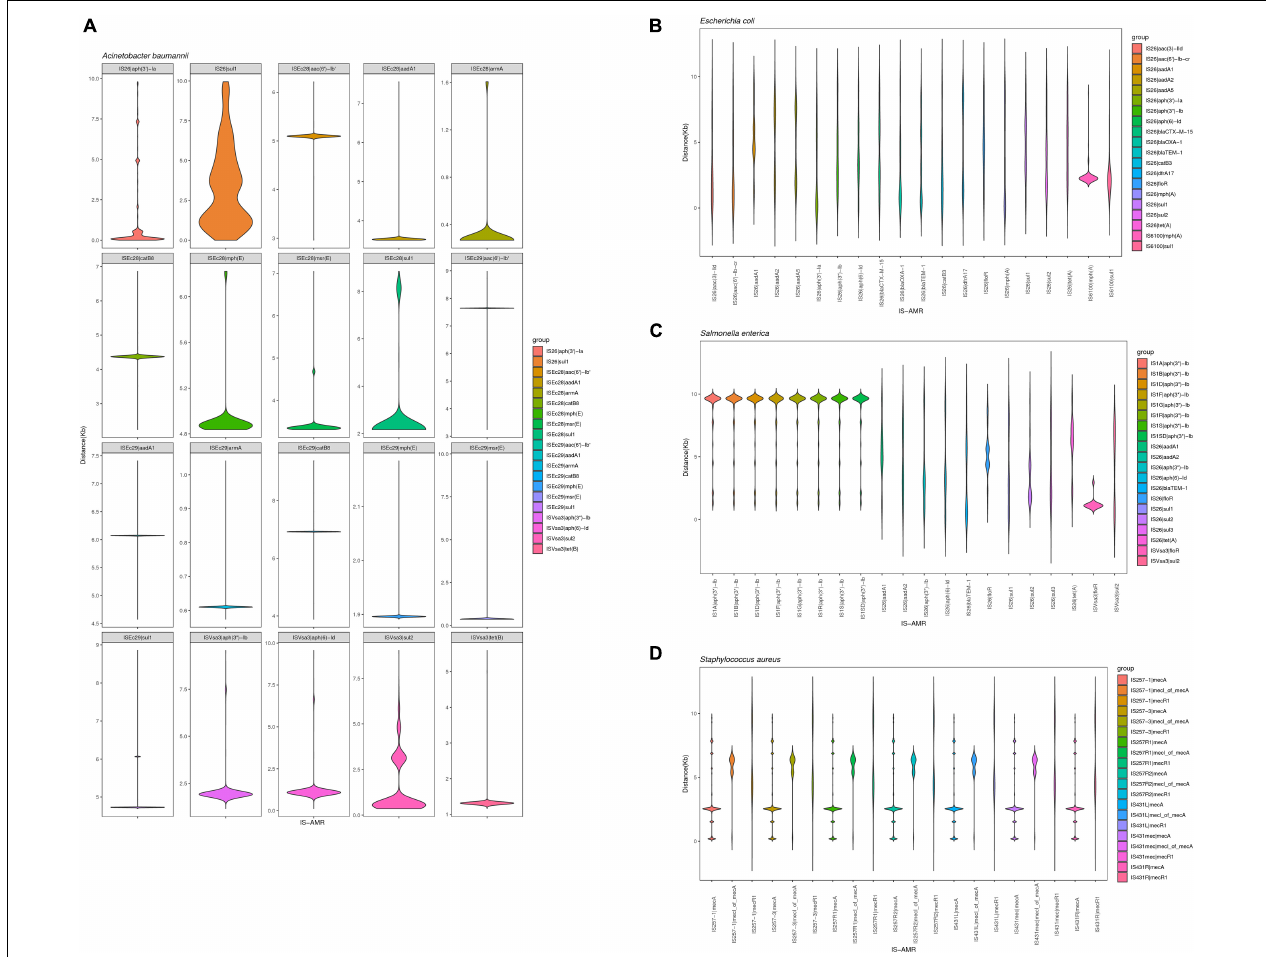
FIGURE 6 | Violin plots showing distribution of the physical distance of top 20 ARG-IS pairs in (A) A. baumannii , (B) E. coli , (C) S. enterica, and (D) S. aureus .